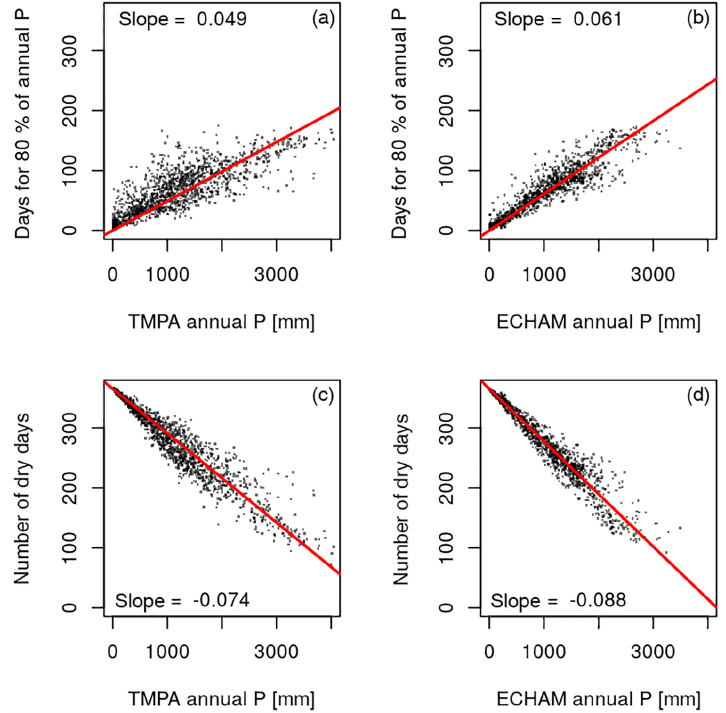
Figure B1. Relationship between annual precipitation and precipitation seasonality and number of dry days, respectively, for the ECHAM simulation used as meteorological forcing for the JSBACH simulations used here and the TMPA 3B42 daily data set. Slope indicates the slope of the regression